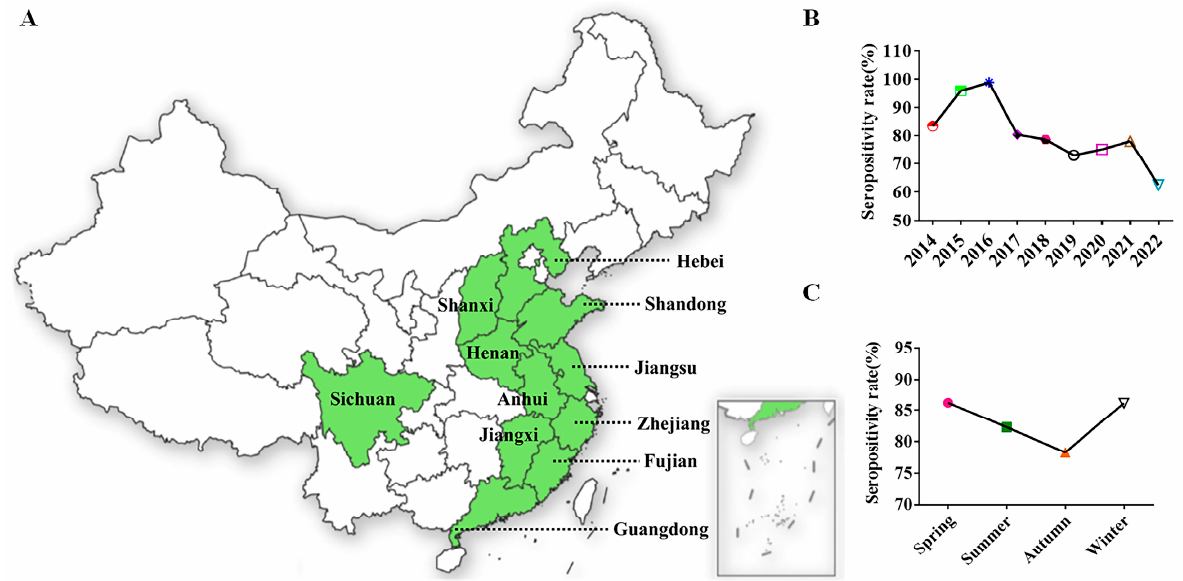
Figure 4. Retrospective epidemiological survey in China. ( A ) The area of light green in the map represents the sampled provinces (locations of sample collection). ( B ) SVA infection in 11 provinces from 2014 to 2022. ( C ) Seasonal epidemic distribution of SVA.